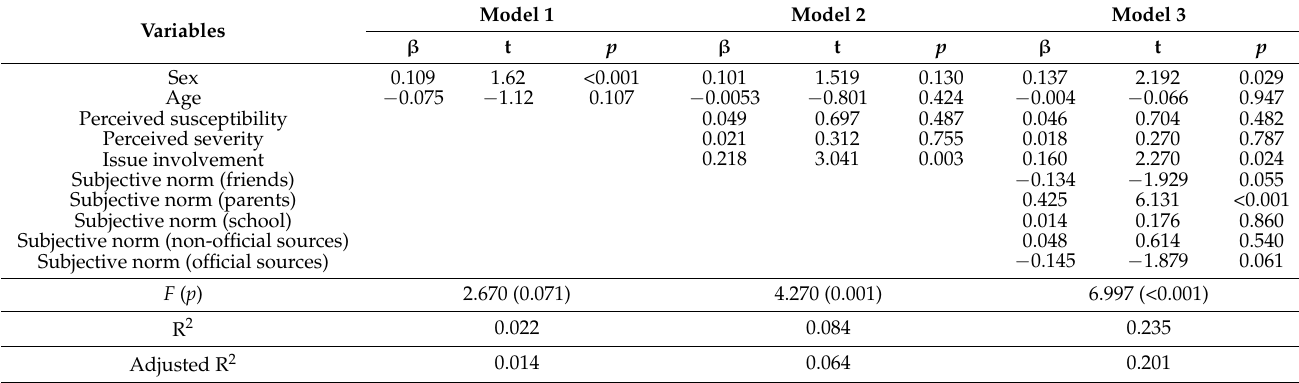
Table 4. Factors related to COVID-19 preventive behaviors among emerging